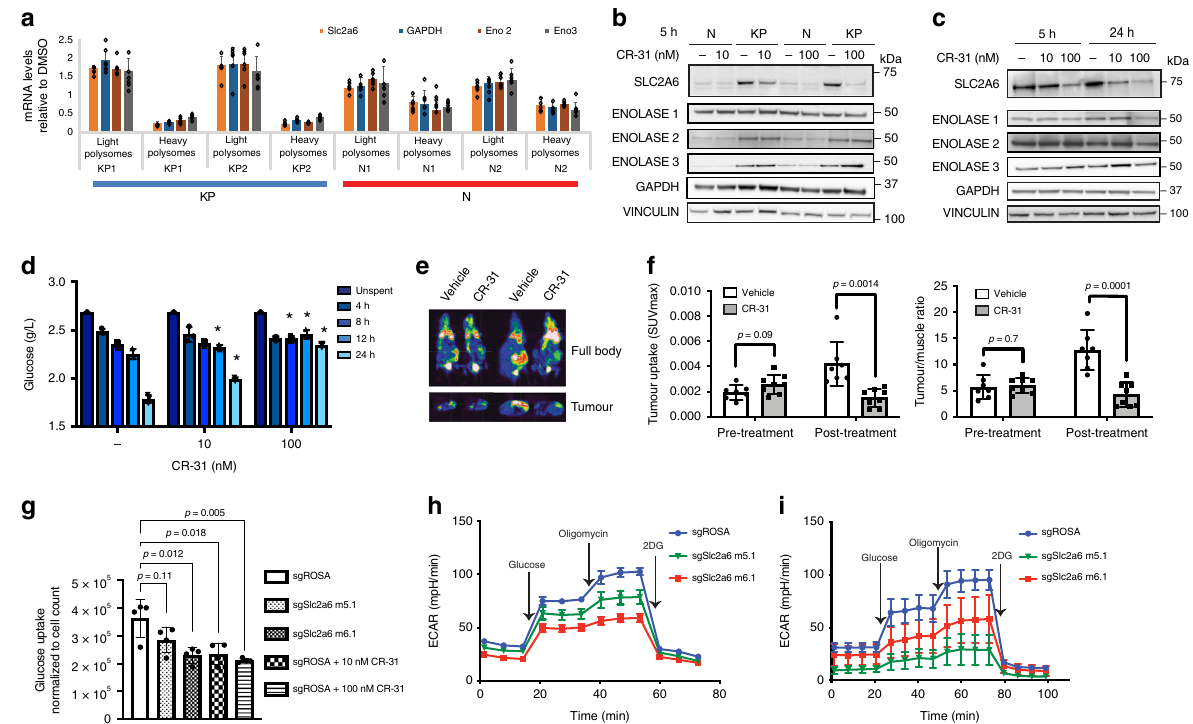
Fig. 5 CR-31 translationally targets glucose uptake in PDA. a Levels of transcripts encoding glycolytic proteins in light (<3 ribosomes) or heavy ( ≥ 3 ribosomes) polysome fractions from N or KP organoids treated with 10 nM CR-31 for 1 h relative to vehicle. Data are mean + / − S.D. n = 6. b Immunoblot analysis of SLC2A6, ENOLASE 1, ENOLASE2, ENOLASE 3, and GAPDH in N and KP organoids upon vehicle or CR-31 treatment for 5 h. Vinculin, loading control. c Immunoblot analysis of SLC2A6, ENOLASE1, ENOLASE2, ENOLASE3, and GAPDH in patient-derived PDA lines upon vehicle or CR-31 treatment. VINCULIN, loading control. d Glucose concentration in media spent from KP organoids upon treatment with vehicle or CR-31. Data are mean + / − S.D., Student ’ s t -test, n = 3. * p < 0.05, compared to DMSO treatment at the same timepoint. e Representative 18 F-FDG-PET images of pancreatic tumours from mice after 24 h of treatment with vehicle or CR-31. Top, coronal view; bottom, transverse view. f Tumour uptake plots comparing initial metabolic activity before and after treatment with vehicle or CR-31. Left, maximum standardized uptake value (SUV) max of tumour. Right, ratio of (SUV) max in tumour compared to muscles. Data are mean + / − S.D., Student ’ s t -test. n = 7, Vehicle; n = 8, CR-31. g Glucose uptake comparing Cas9-expressing murine PDA cell lines transduced with sgRNAs targeting the ROSA locus (sg ROSA ) or against different regions of the Slc2a6 gene (sg Slc2a6 ). Data are mean + / − S.D., normalized to cell numbers. Student ’ s t -test, n = 4. h ECAR was measured in equal numbers of Cas9-expressing primary murine PDA cell lines transduced with sgRNAs targeting the ROSA locus (sg ROSA ) or different regions of the Slc2a6 gene (sg Slc2a6 ). ECAR was measured following the addition of glucose, Oligomycin, and 2DG. Data are mean + / − S.D., n = 5. i ECAR was measured in equal numbers of Cas9-expressing KP organoids transduced with sgRNAs targeting the ROSA locus (sg ROSA ) or different regions of the Slc2a6 gene (sg Slc2a6 ). ECAR was measured following the addition of glucose, Oligomycin, and 2DG. Data are mean + / − S.D., n = 6. Source data are provided as a Source Data fi